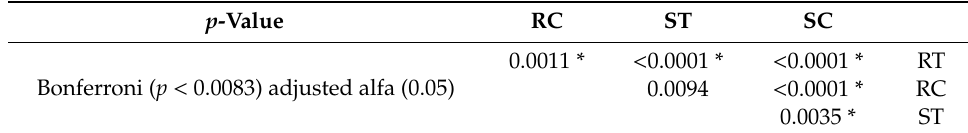
Table 2. Hotelling’s T 2 -test comparing the relative concentration of OPPs in rice and soil from Thailand and China. p